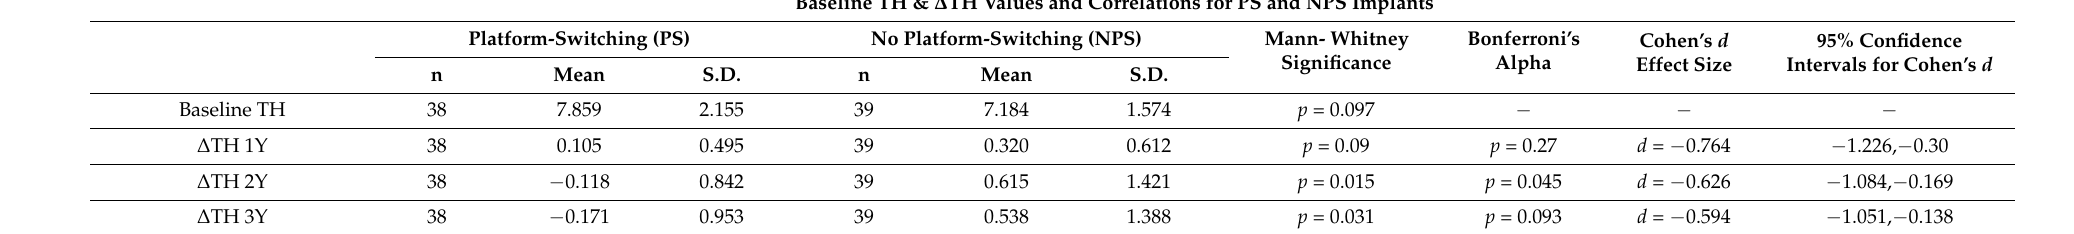
Table 4. Correlation between prosthetic crown height variation ( ∆ TH) and presence or absence of platform-switching at one, two, and three years. Difference becomes significant (Mann–Whitney, 95% conf.) at two and three years from delivery of final crown. Baseline TH & ∆ TH Values and Correlations for PS and NPS